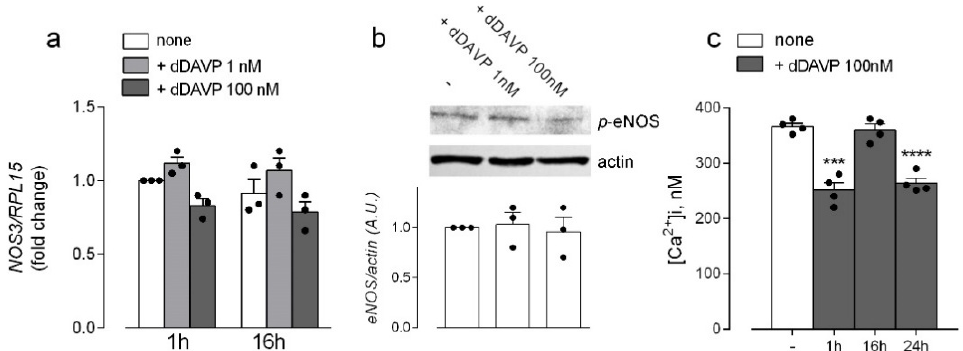
Figure 4. Effects of desmopressin on the expression and activity of endothelial nitric oxide synthases in microvascular endothelial cells. HLMVEC were maintained in the presence of the indicated concentrations of dDAVP. ( a ) The expression of NOS3 was measured after 1 and 16 h with RT-qPCR and normalized for that of the housekeeping gene RPL15. Data are means ± SEM of three experiments, each performed in duplicate. ( b ) The phosphorylation of eNOS in Ser1177 was monitored by means of Western Blot analysis, as described in Material and Methods. A representative blot is shown that, repeated three times, gave comparable results; the graph represents the mean ± SEM of the results from the densitometric analyses of the different experiments ( c ) Intracellular calcium levels were measured in cells treated for the indicated times at steady-state and calibrated as described in Material and Methods. Data are mean ± SEM of four independent determinations. *** p < 0.001, **** p < 0.0001 vs. control (-), with a two tailed Student’s t -test for unpaired data.